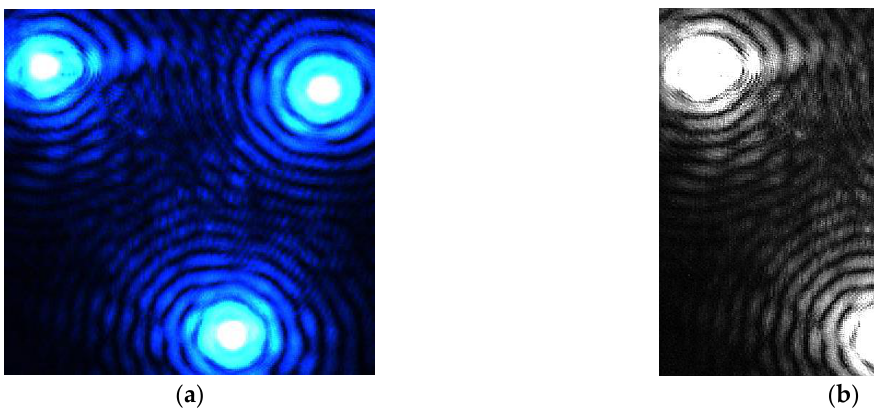
Figure 9. ( a ) An experimental optical fringe pattern and ( b ) its grayscale version.